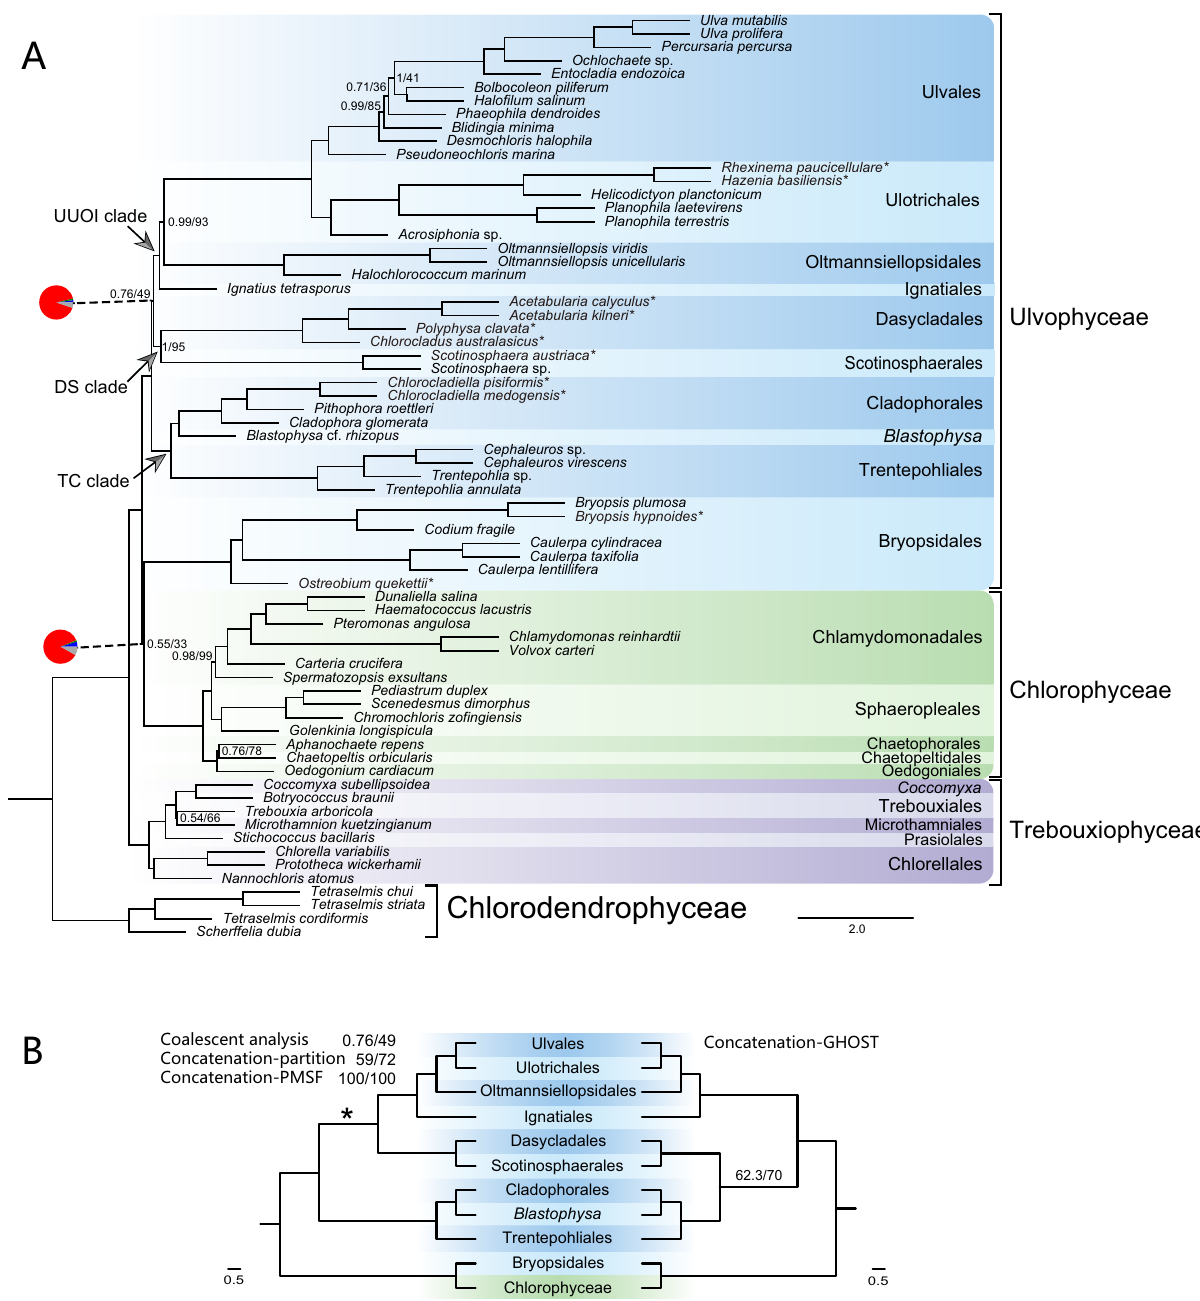
Fig. 2 Phylogenetic relationships of Ulvophyceae inferred from 884 nuclear genes. A Species tree based on the multispecies coalescent model. Support for each node is provided by local posterior probability and multi-locus bootstrapping (PP/MLBS). Nodes without a value indicate full support. The pie charts at two focal nodes of Ulvophyceae present the proportion of gene tree concordance and con fl ict. Pie chart color coding: blue, fraction of gene trees that are concordant with the species tree; green, fraction of gene trees supporting the second most common con fl icting topology; red, fraction of gene trees supporting all other alternative con fl icting partitions; gray, fraction of gene trees with <50% bootstrap support at that node. The newly sampled species are marked with a symbol (*). Note that Desmochloris has been placed in the Chlorocystidales 105 , and Pseudoneochloris has been recently placed in a new order, Sykidiales 106 . B Topological comparison among coalescent- and concatenation-based analyses. Support for the con fl icting branches is provided by PP/ MLBS (in coalescent-based analysis) and SH-aLRT/ultrafast bootstrap (in concatenation-based analyses). The asterisk indicates support in the three analyses on the left. The source data of the pie charts in ( A ) are provided in the Source Data fi le. divergence times in ulvophycean evolutionary history. Time- the Ulvophyceae reconstructed by the multispecies coalescent calibrated phylogenetic analyses were performed using a Bayesian model as a framework for subsequent analyses. relaxed clock model in MCMCTree, based on the coalescent species tree and 200 most clock-like genes. We compared the Time-calibrated phylogeny of the Ulvophyceae . Our phyloge- posterior distributions to the effective prior distributions for the different calibrated nodes (Supplementary Fig. 5). The effective nomic results provided a phylogenetic framework for estimating NATURE COMMUNICATIONS| (2022) 13:1610